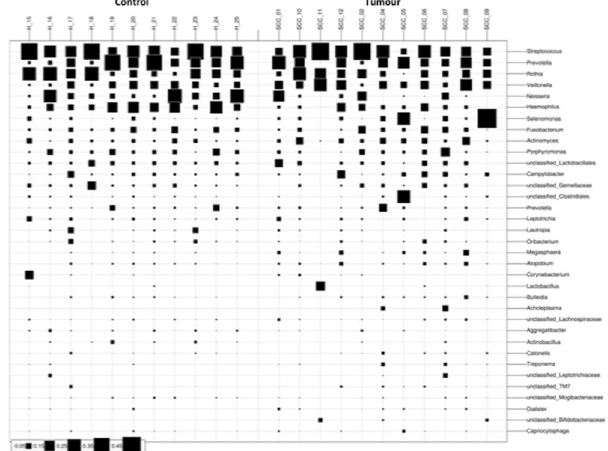
Figure 1. Bubbleplot of the 35 most abundant bacterial genera detected in saliva samples of healthy controls (‘H’) and cancer patients (‘SSC’).